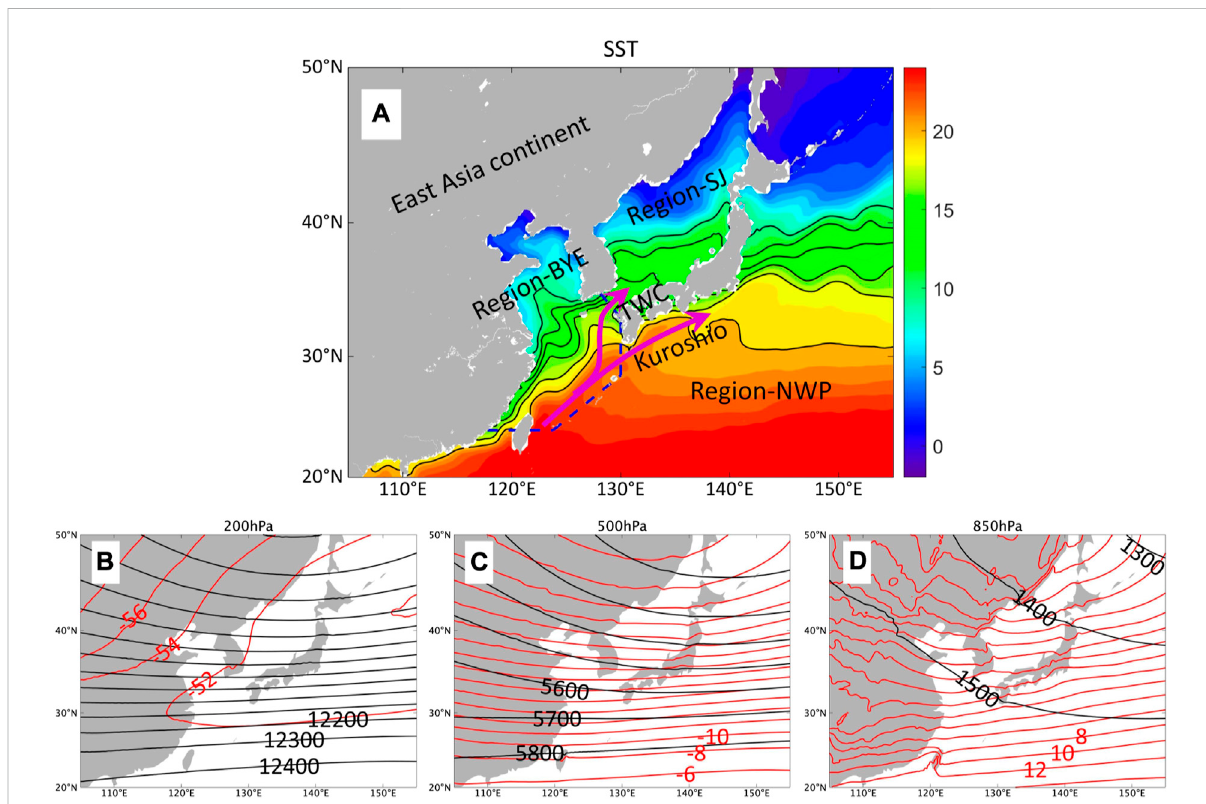
FIGURE 1 SST (A) andsynopticfeaturesat200 hPa (B) ,500 hPa (C) ,and850 hPa (D) averagedinwintersduring2010 – 2019.Contoursin (A) showtheSST within 10 – 20 ° C with an interval of 2 ° C. Blue dashed lines divide the ocean into three regions: Region-BYE (including the Bohai Sea, the Yellow Sea, and the East China Sea), Region-SJ (the Sea of Japan), and Region-NWP (the Northwestern Paci fi c). “ TWC ” denotes the Tsushima Warm Current. Black and red contours in (B – D) represent GPH (gpm) and air temperature ( °